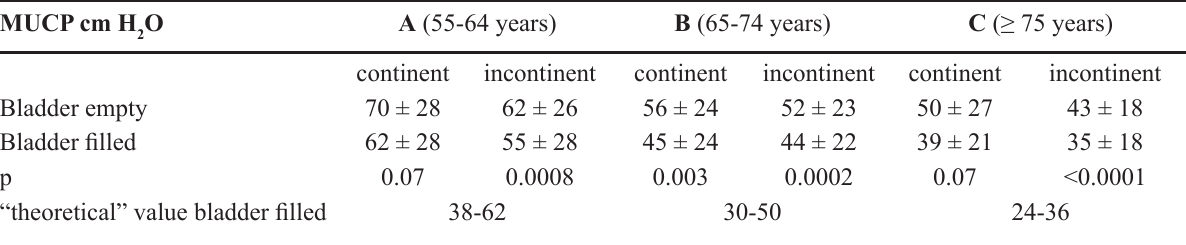
Table 7 – Maximal urethral closure pressure (MUCP) vs. age and continence